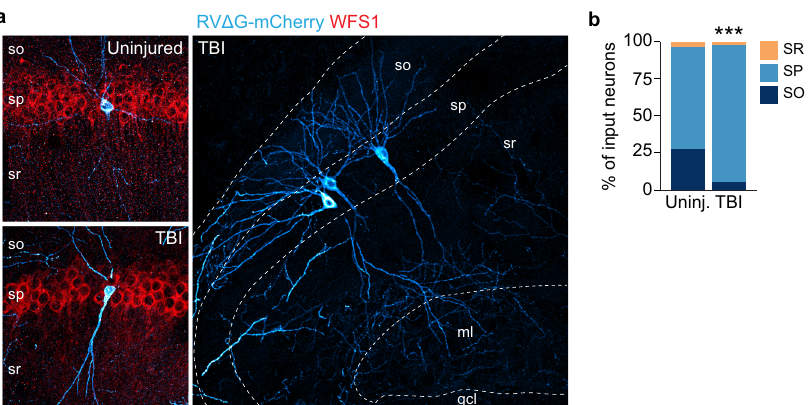
Fig. 4 Identi fi cation of CA1 input neurons. a CA1 in uninjured control (top) and brain injured animal (bottom) labeled for rabies (blue) and WFS1 (red). Representative animals from n = 3 uninjured and 4 TBI mice. so, stratum oriens; sp, stratum pyramidale; sr, stratum radiatum; ml, molecular layer; gcl, granule cell layer. b Proportion of input neurons found in each layer of CA1. *** P = 1.29E-07, uninjured versus TBI, two-sided Chi-squared test. n = 45 cells from 3 uninjured controls, 183 cells from 4 TBI mice. Scale bars, 100 μ m. See also Supplementary Data 1. Source data are provided as a Source Data